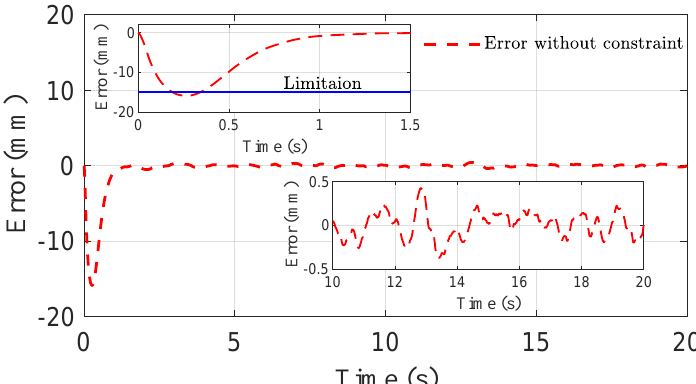
Figure 6. Error comparison of quarter vehicle with AAS in co-simulation, where | z 1 | exceeds its allowable maximum value.